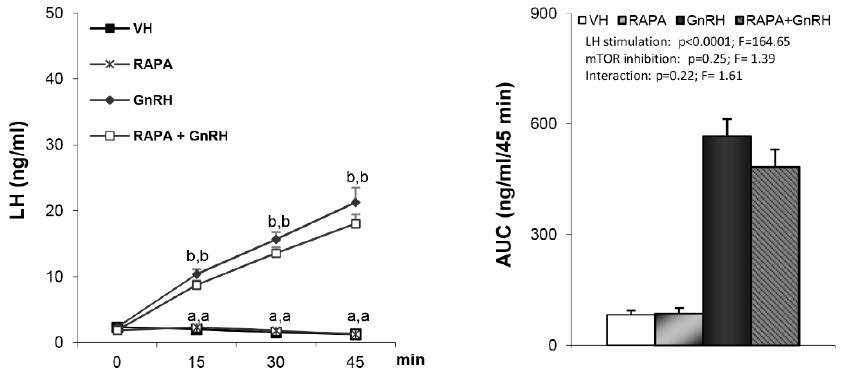
Figure 5. Levels of LH secretion and AUC after treatment; VH (5 µL DMSO icv plus 200 µL saline iv), RAPA (50 µg rapamycin icv plus 200 µL saline iv), GnRH (5 µL DMSO icv plus 32.5 nmol/kg iv) or RAPA + GnRH (50 µg rapamycin plus 32.5 nmol/kg iv). Administration of the peptides took place after stabilization of the animals following the third sampling point (indicated as time 0). Values are given as the mean ± SEM. p < 0.05; two-way ANOVA repeated measures followed, in case of hormone profile, by a post hoc Bonferroni’s test (groups with different superscript letters are statistically different).